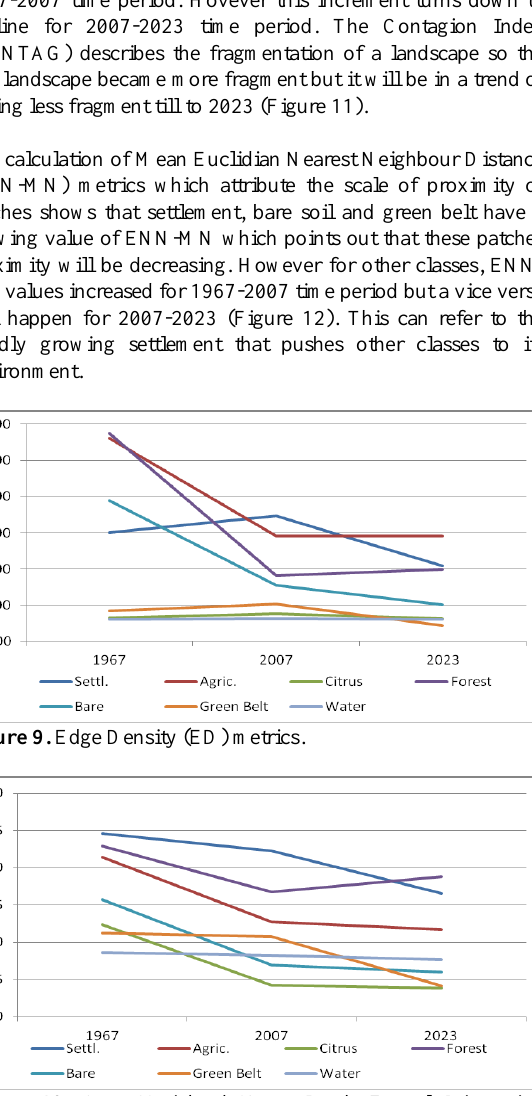
Figure 10. Area Weighted Mean Patch Fractal Dimension (FRAC-AM) metrics.